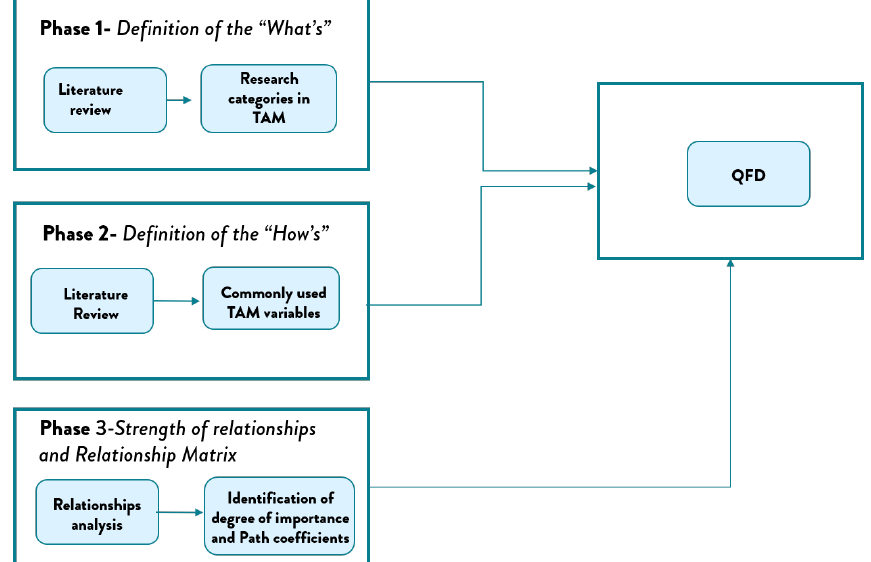
Figure 2. Layout of the proposed